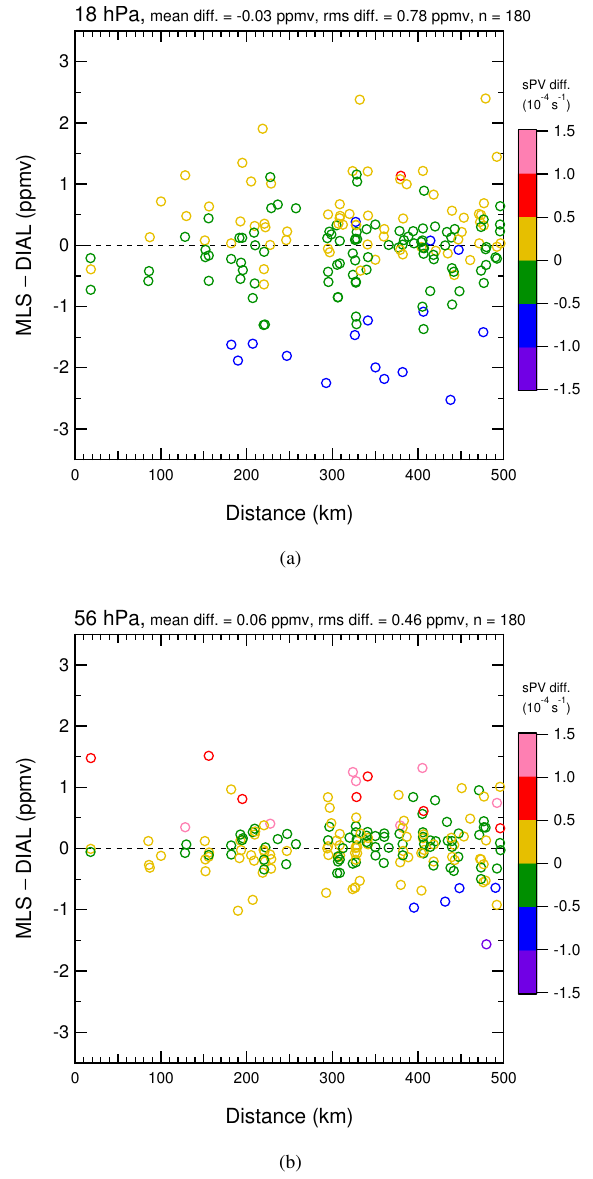
Figure 9. O 3 difference versus distance for DIAL and MLS at 18hPa (a) and 56hPa (b) . Data are color coded based on sPV dif- ferences between DIAL and MLS